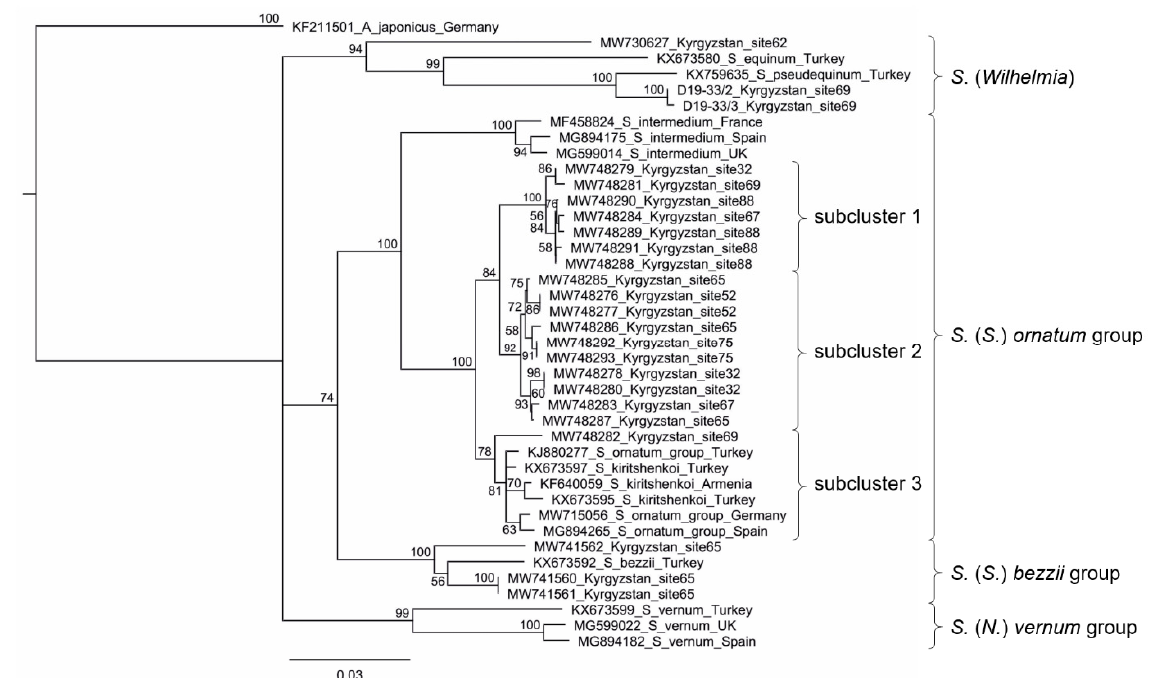
Figure 5. Partial CO1 sequence-based neighbor-joining tree showing the Simulium ornatum group, associated black flies in our samples, and selected reference species from GenBank. Aedes japonicus (Diptera: Culicidae) was used as an outgroup. Statistical support of 1000 bootstraps is indicated at the nodes. The scale bar represents the number of substitutions per site. D19-33/2 and D19-33/3 are laboratory identification numbers; these sequences could not be assigned to a species or species group and therefore could not be entered into GenBank.